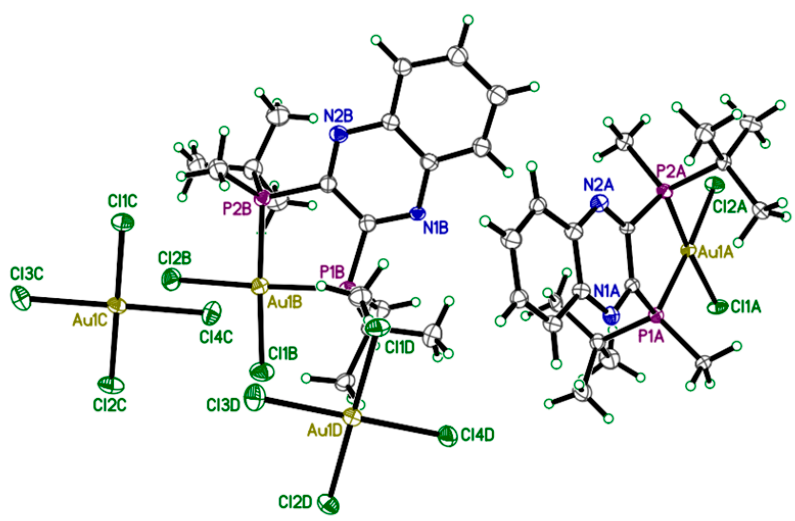
Table 1. Selected interatomic distances (Å) and angles (deg) from the crystal structure of complex 2 , shown in Figure 2.